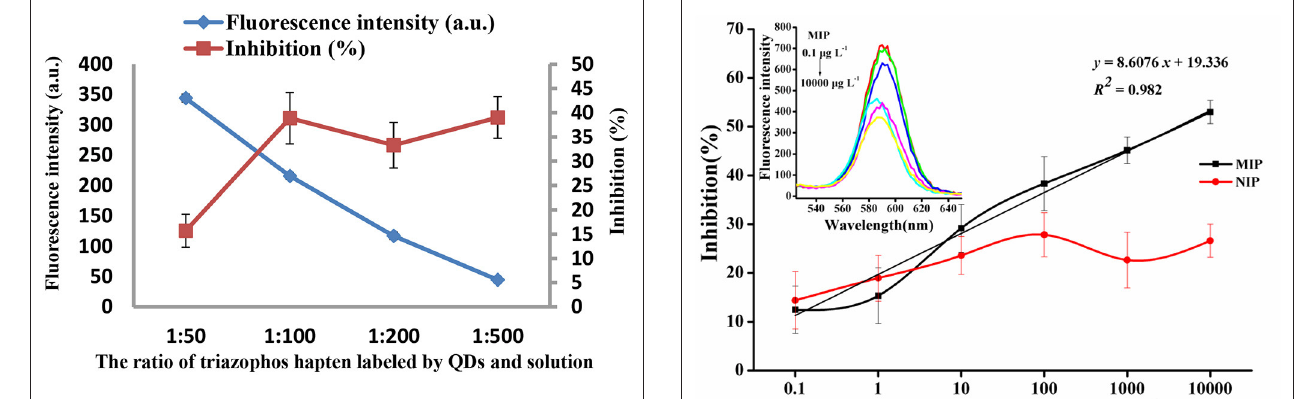
efficiency of CdSe/ZnS QDs was high when the competition time was set at 60